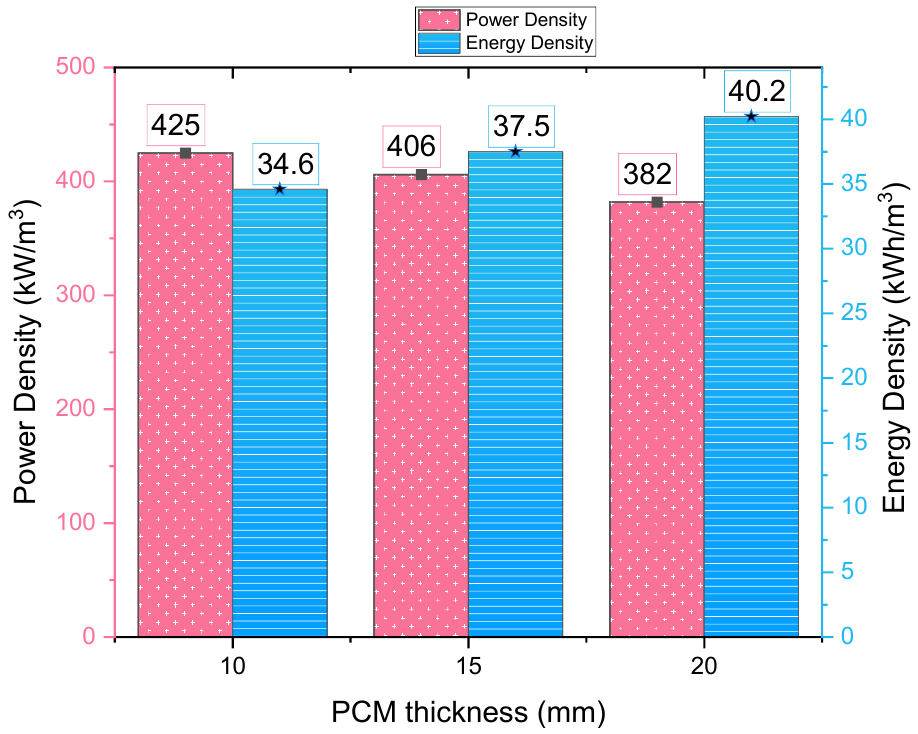
Figure 16. Power and energy density of the storage tanks with different PCM thickness.